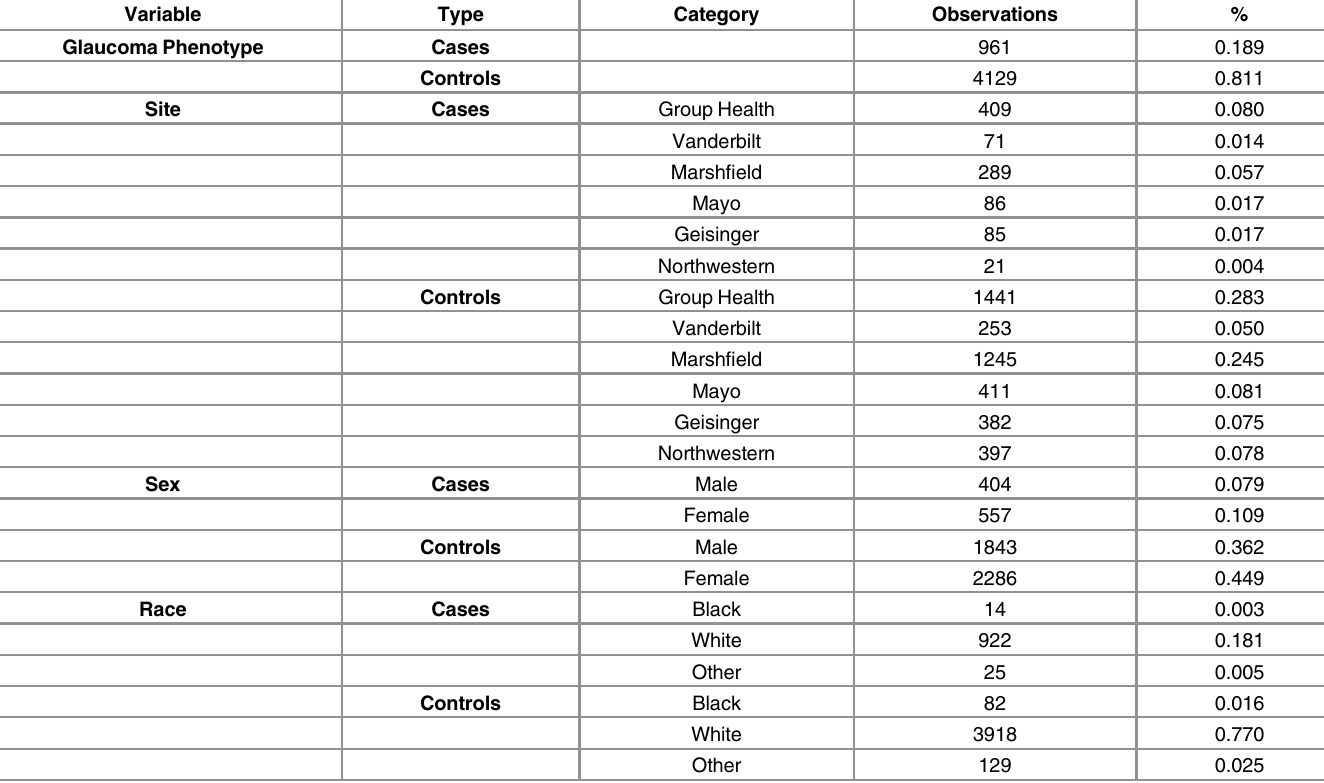
Table 3. Demographics for glaucoma samples in eMERGE discovery